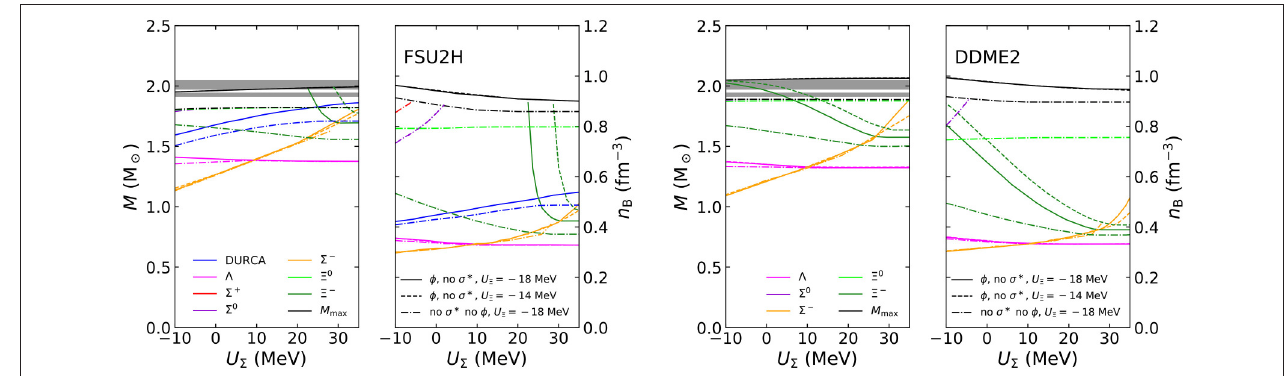
FIGURE 9 | The same as in Figure 7 for different values of U 6 , U 4 and x φ Y and for models FSU2H and DDME2.